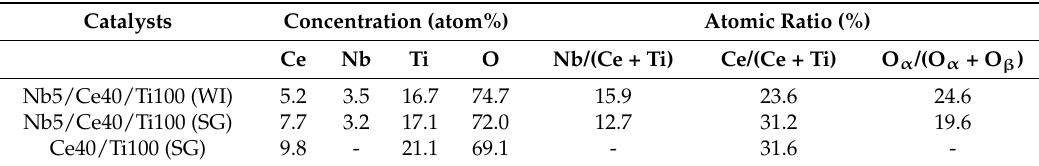
Table 4. Surface composition and element ratios of the supported Ceria-containing catalysts calculated from